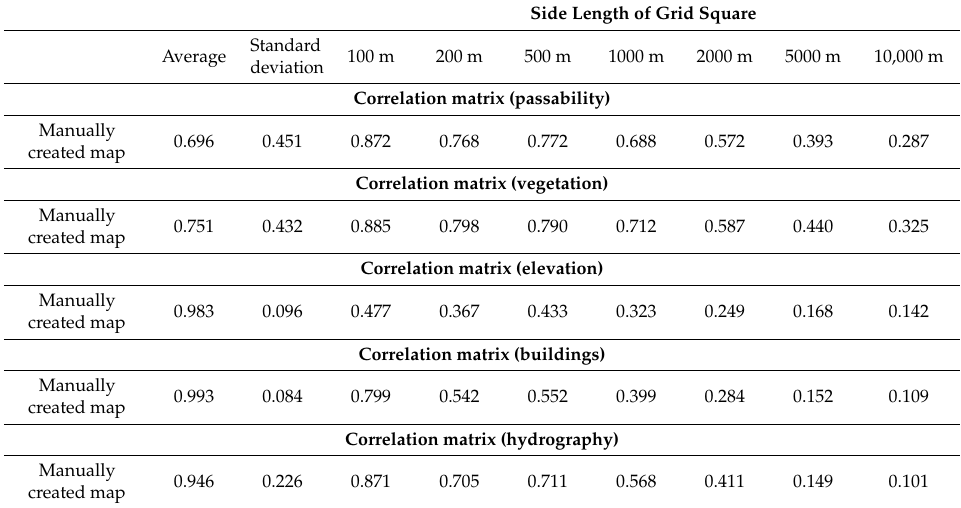
Table 11. Correlation matrices and basic statistic parameters for the 1000 m mesh control points grid.